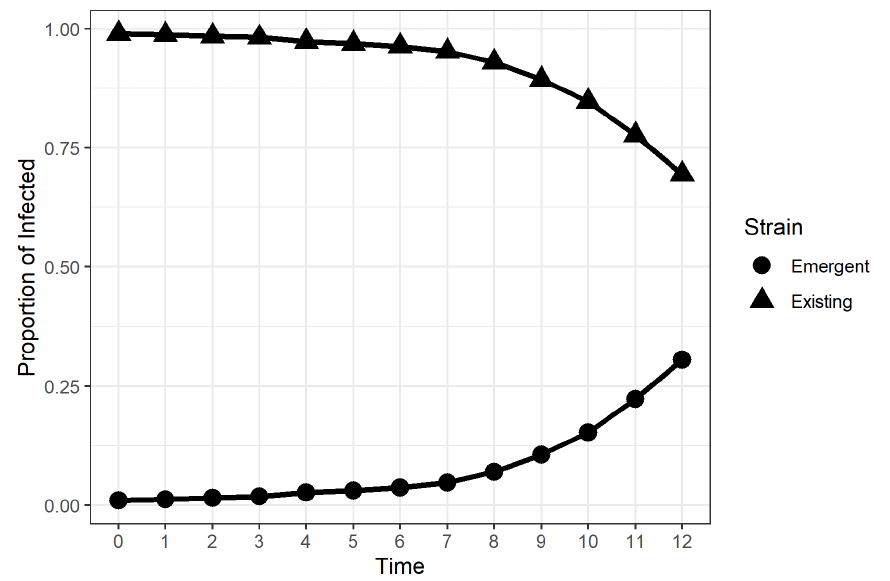
Figure 3. A sample run for the factor combination ( β , β (cid:48) / β , ν , v ( 0 ) ) = (1.4,1.25,0,0). The proportion of emergent strain infections among the infected did not go above 0.5, despite observing a steady increase in infections.